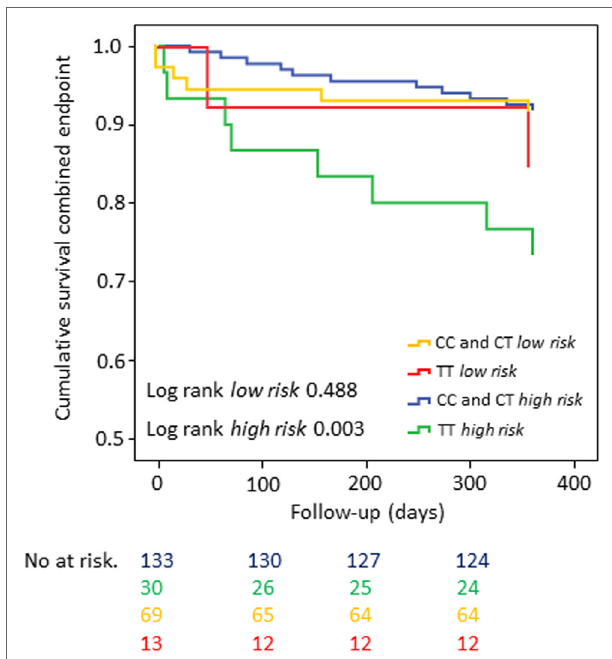
FigUre 3 | Kaplan–Meier curves showing cumulative survival (combined endpoint) stratified according to GP la rs1126643 homozygous and heterozygous carriers of major allele versus homozygous carriers of minor allele in a patient collective at high cardiovascular risk. No. at risk: blue = homozygous and heterozygous carriers of major allele ( high risk ), green = homozygous carriers of minor allele ( high risk ), yellow = homozygous-and heterozygous carriers of major allele ( low risk ), red = homozygous carriers of minor allele ( low risk